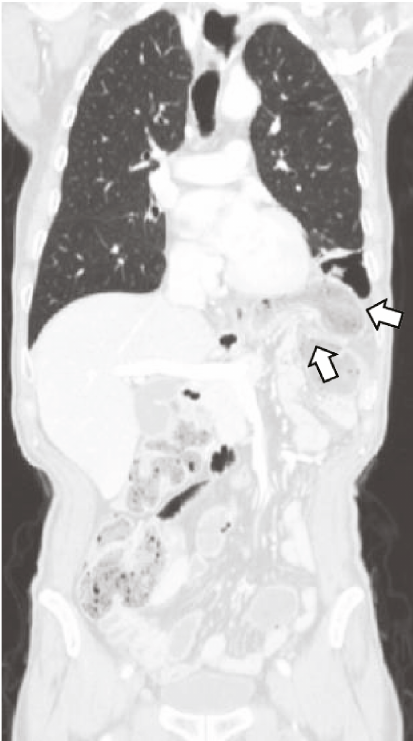
Figure 3: CT scan performed during the oncological follow-up. The diaphragmatic hernia was clearly visible but has not been described in the radiological report. Left side diaphragmatic defect (lower arrow); abdominal viscera in the left hemithorax (upper